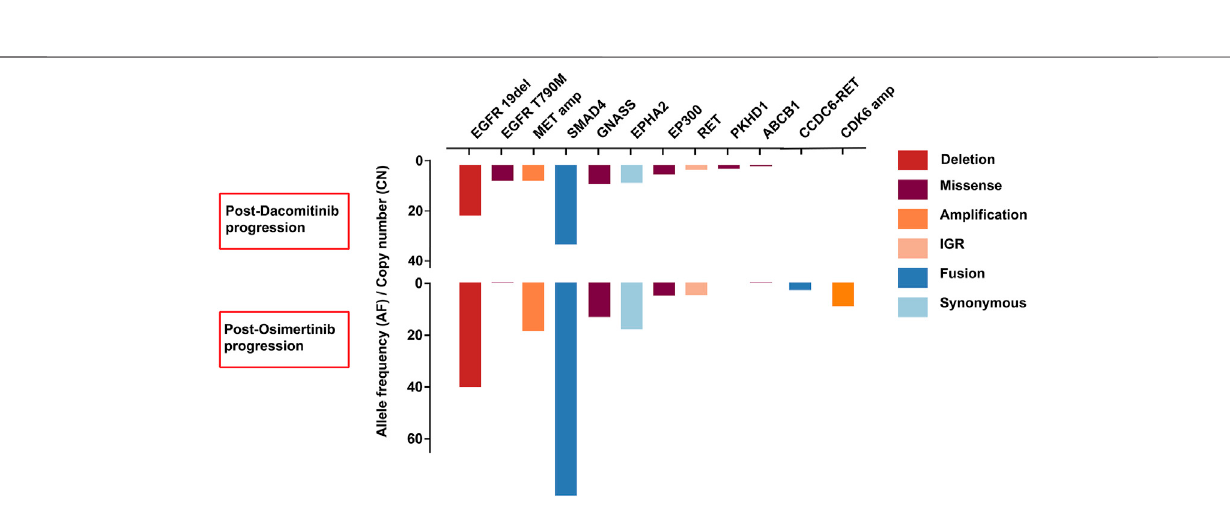
Frontiers in Pharmacology |